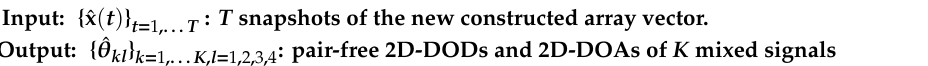
Table 1. Summary of the proposed method.